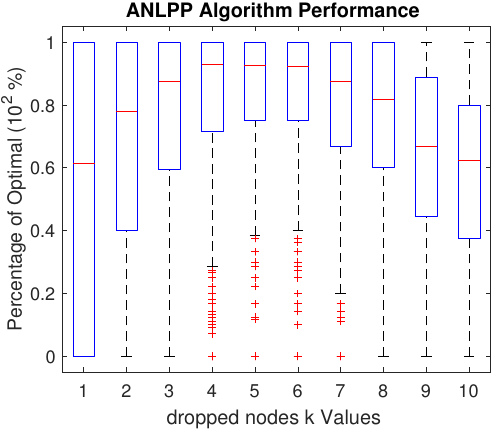
Figure 10. The impact of k , the number of drop nodes, on ANLPP performance, when tuned for k =